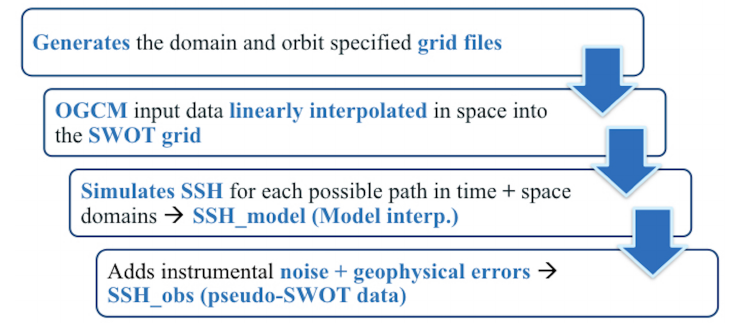
Figure 1. Flowchart of the SWOT simulator